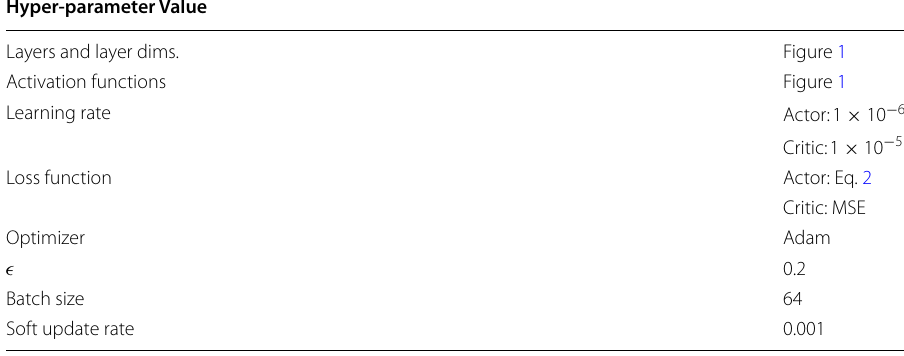
Table 2 Hyper-parameters of the PPO model Hyper-parameter Value Layers and layer dims. Figure 1